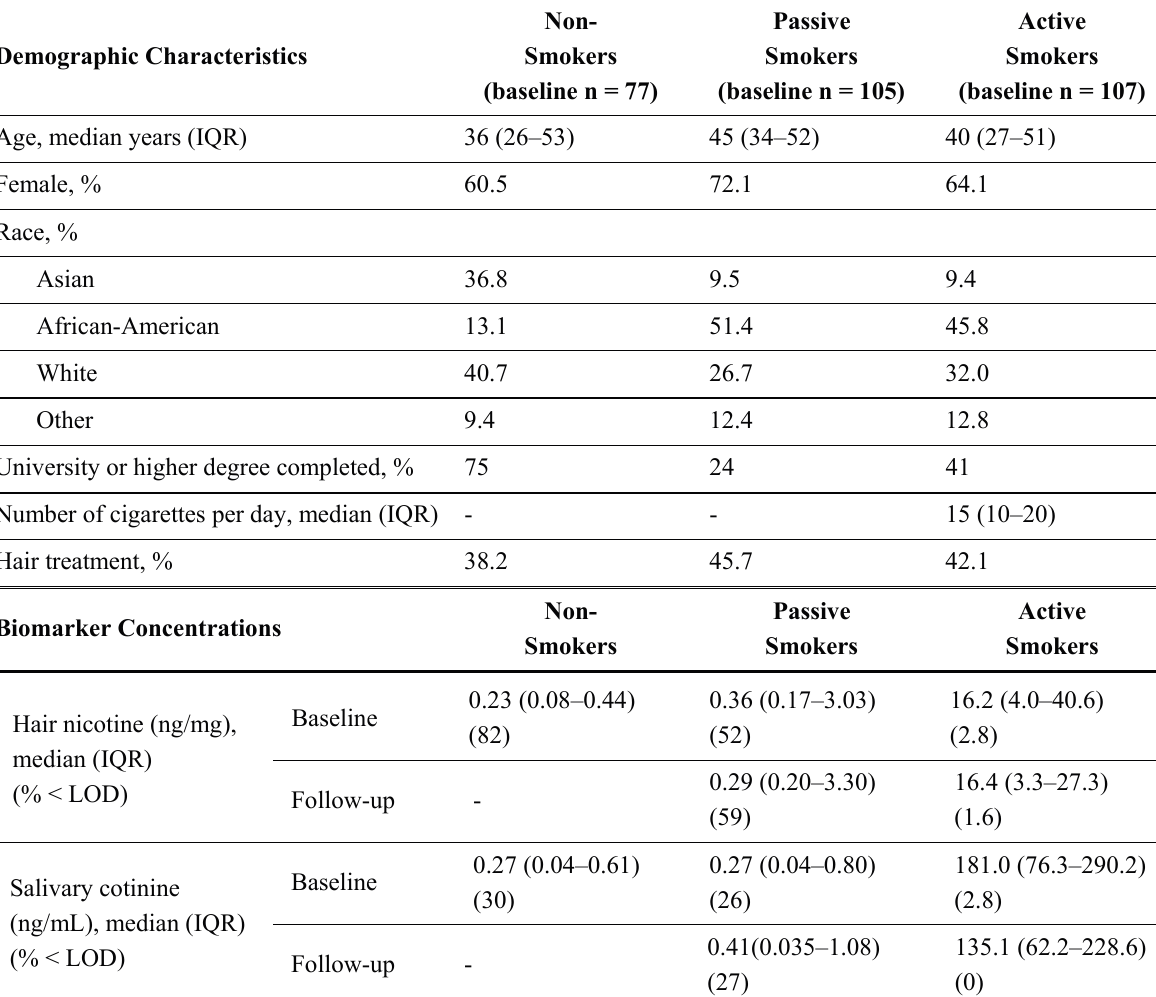
Table 1. Demographic characteristics and biomarker concentrations of study population by self-reported smoking